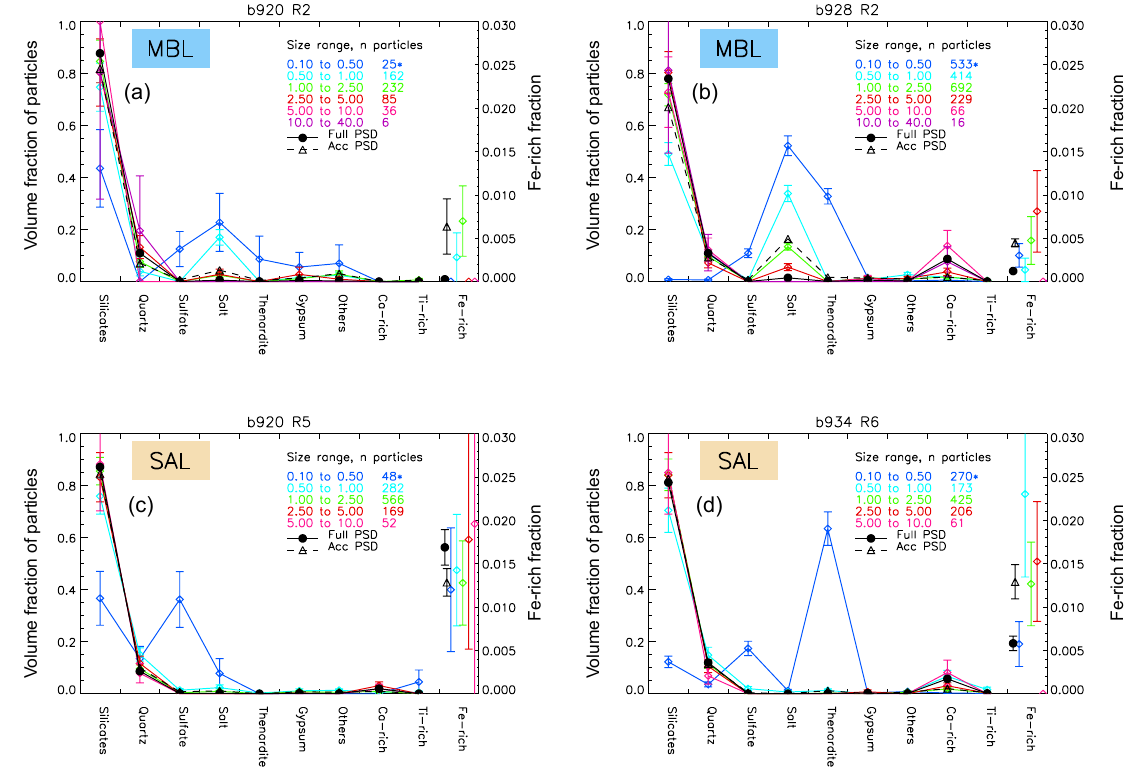
Figure 11. Composition as volume fraction from filter samples in the MBL (a, b) and SAL (c, d) . B928 R2 (b) contained a substantial giant mode in the MBL (e.g. see Figs. 5 and 7). Individual panels indicate number of particles sampled; an asterisk indicates numbers were scaled-up from the value shown to allow for different substrate areas at the higher magnification. The Fe-rich volume fraction is provided on the right axis with different size ranges offset. Data are also shown as bulk properties for the full PSD and accumulation mode ( d <2.5µm) and size resolved. Data are only shown when the sample size is greater than 5. Error bars count